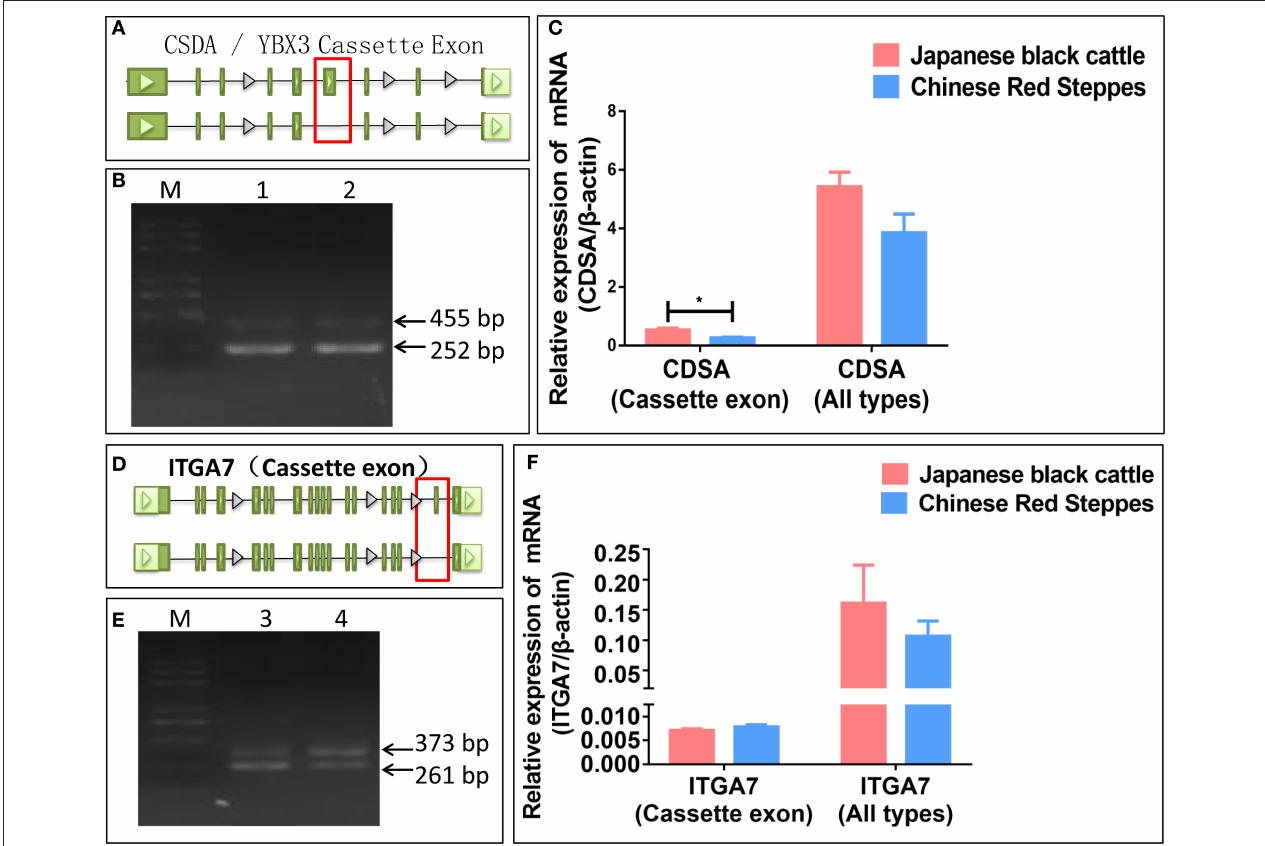
FIGURE 4 | Verification of splicing type and expression level. (A) The alternative splicing pattern of CDSA. (B) PCR validation of CDSA (Cassette). (C) The relative expression levels of CDSA. (D) The alternative splicing pattern of ITGA7. (E) PCR validation of ITGA7 (Cassette). (F) The relative expression levels of ITGA7. (1) CDSA PCR product of LDM in Japanese black cattle, (2) CDSA PCR product of LDM in Chinese Red Steppes, (3) ITGA7 PCR product of LDM in Japanese black cattle, and (4) ITGA7 PCR product of LDM in Chinese red steppes (M) trans 2K Plus DNA Marker. Green blocks represent